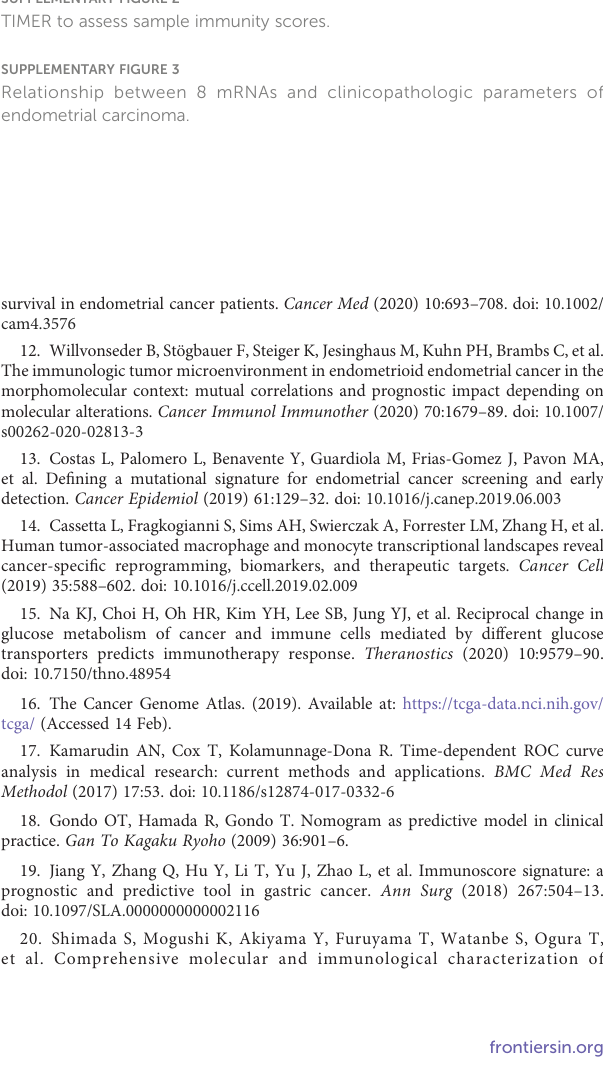
SUPPLEMENTARY FIGURE 1 (A) Decision Curve Analysis (DCA) of the model (The red line represents the curve of Riskscore) (B) Calibration Curve Analysis(CCA) of the model. SUPPLEMENTARY FIGURE 2 TIMER to assess sample immunity scores. SUPPLEMENTARY FIGURE 3 Relationship between 8 mRNAs and clinicopathologic parameters of endometrial